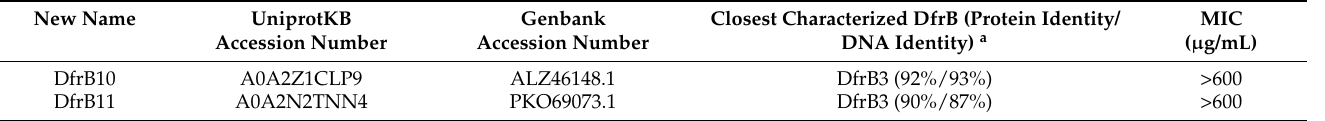
Table 1. Information and MICs on the newly identified DfrB10 and